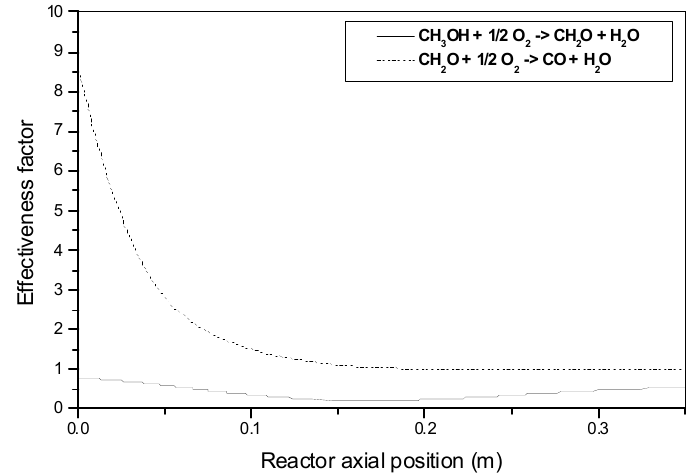
Figure 18. Axial profiles for the effectiveness factor for the two reactions.